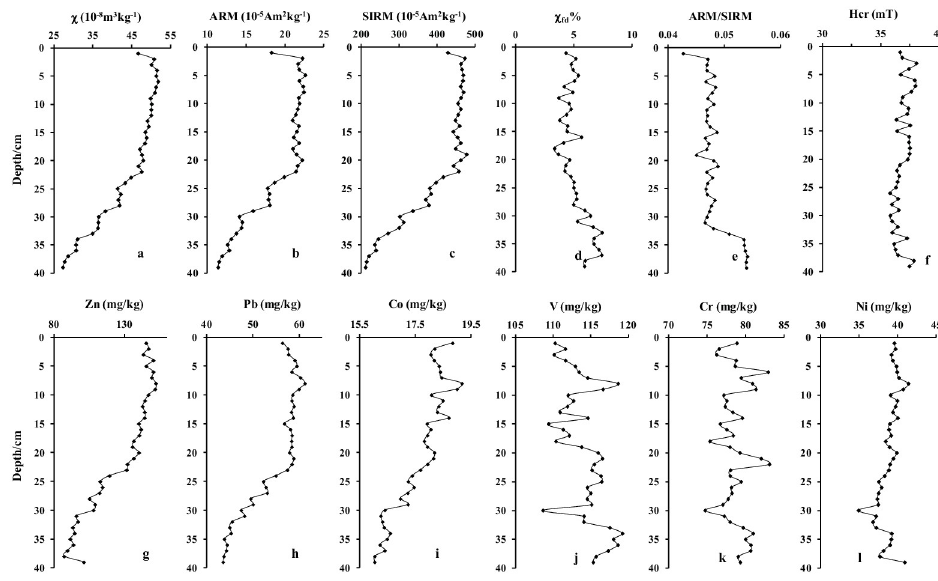
Fig 4. Vertical variations in magnetic parameters (a-f) and heavy metal concentrations (g-l) of core QH1. https://doi.org/10.1371/journal.pone.0255395.g004 Hcr of all samples ranged from 35 mT to 40 mT, indicating that all samples were dominated by soft magnetic minerals such as magnetite and maghemite. As shown in Table 1, we analysed the correlation between the magnetic parameters and each heavy metal element. There were significant positive correlations between ARM , and SIRM , and the correlation coefficient between them was 0.99. However, these three magnetic parameters were negatively correlated with χ % (correlation coefficients (r values) of -0.79 to -0.83) and the ARM / SIRM ratio (r val- fd ues of -0.69 to -0.78). The vertical variations of heavy metals ( Zn , Pb , Co , V , Cr , and Ni ) are also displayed in Fig 5. According to the variation trends, the vertical change of heavy metals were divided into two categories: 1) some heavy metal elements (e.g. Zn , Pb , and Co ) exhibited similar trends to those of χ , ARM , and SIRM (Fig 4g–4i). The trends reveal that these heavy metals increased